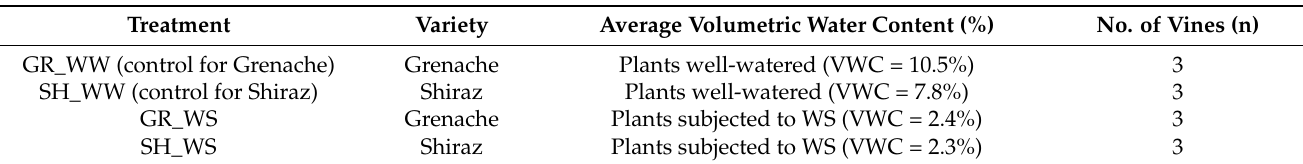
Table 1. Summary table of the treatments applied in this experiment. Day and night temperatures were set at 40 ◦ C and 30 ◦ C,